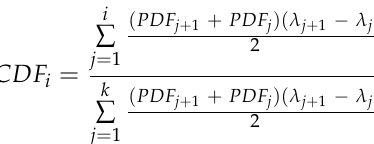
Figure 7A,B represents the PDF and CDF of the white LED,